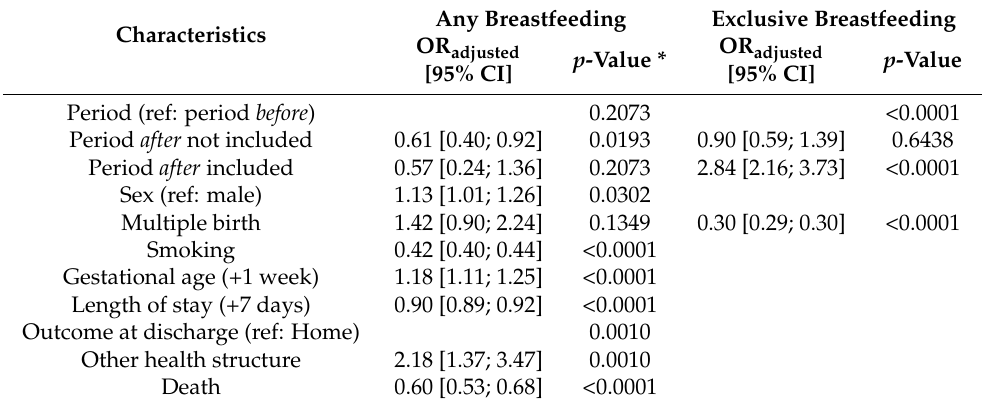
Table 5. Multivariable logistic regression model predicting breastfeeding at hospital discharge in neonates admitted before day 7 of life and intended to be